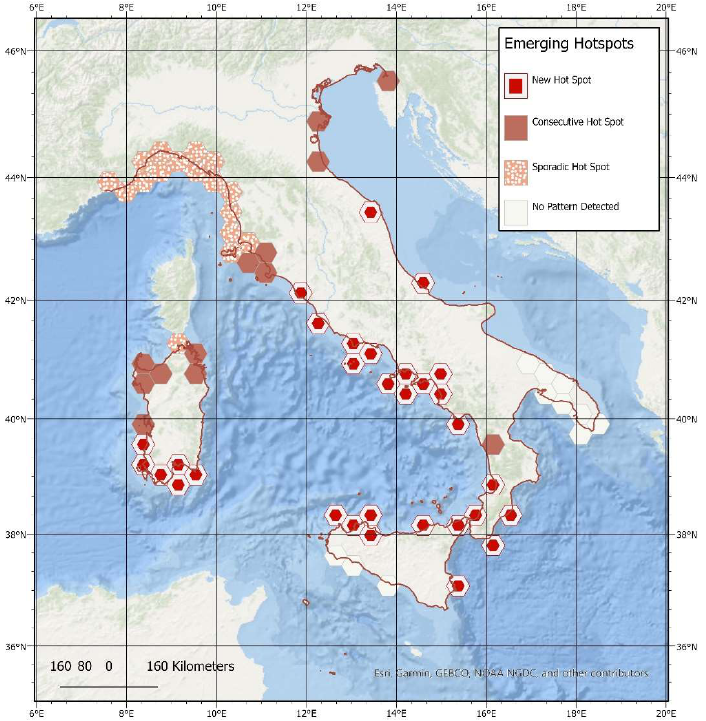
Figure 4. Emerging hot spots obtained from all mortality events from data compiled between the years 1624 and 2021 along the Italian coastline. The Italian coastline is highlighted in red.